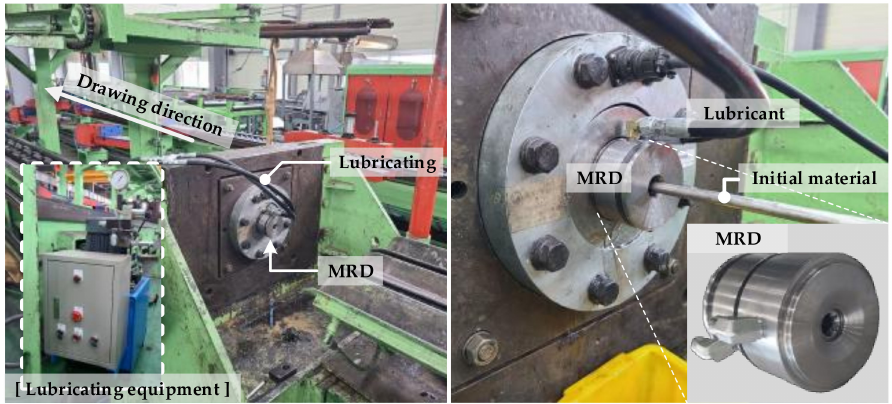
Figure 7. Experiments on the drawing